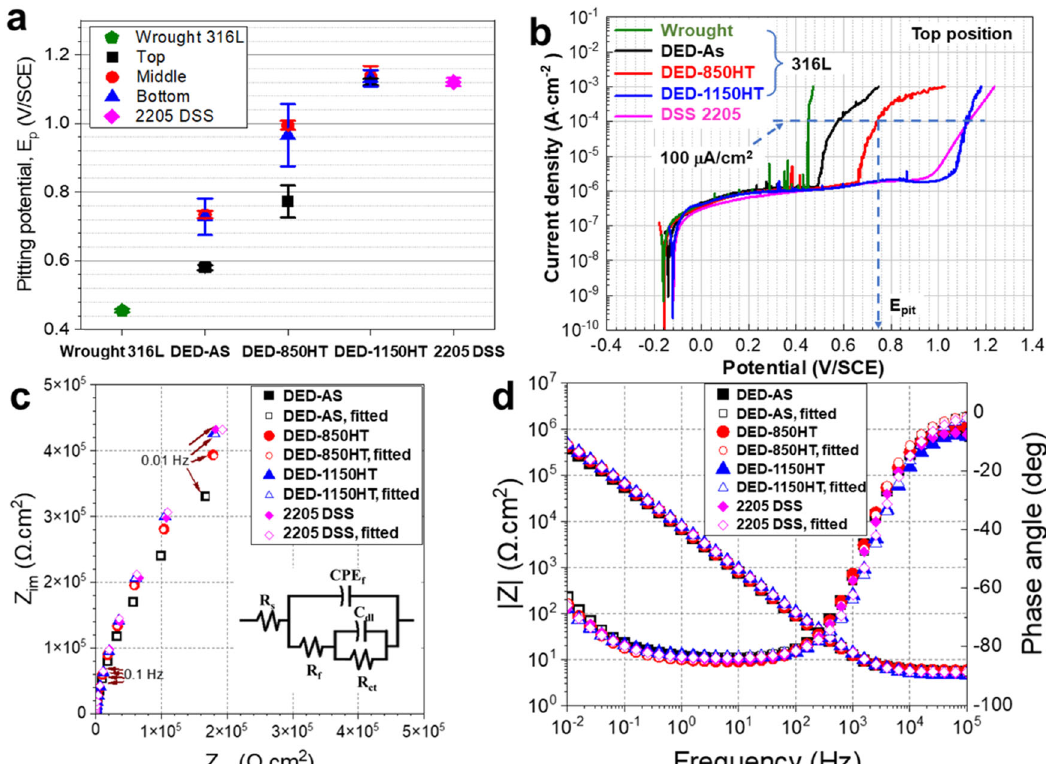
Fig. 5 Electrochemical analysis results. Electrochemical analysis results of the as-manufacture and heat-treated DED 316L SS in 3.5 wt. % NaCl solution: a pitting potentials at different positions and b typical pitting curves (results of wrought 316L SS and 2205 DSS are shown for comparison), c Nyquist plots and d Bode plots including the result of 2205 DSS. The equivalent circuit for EIS fi tting is included in c . Error bars in a show the standard deviations of three measured pitting potentials of corresponding materials.